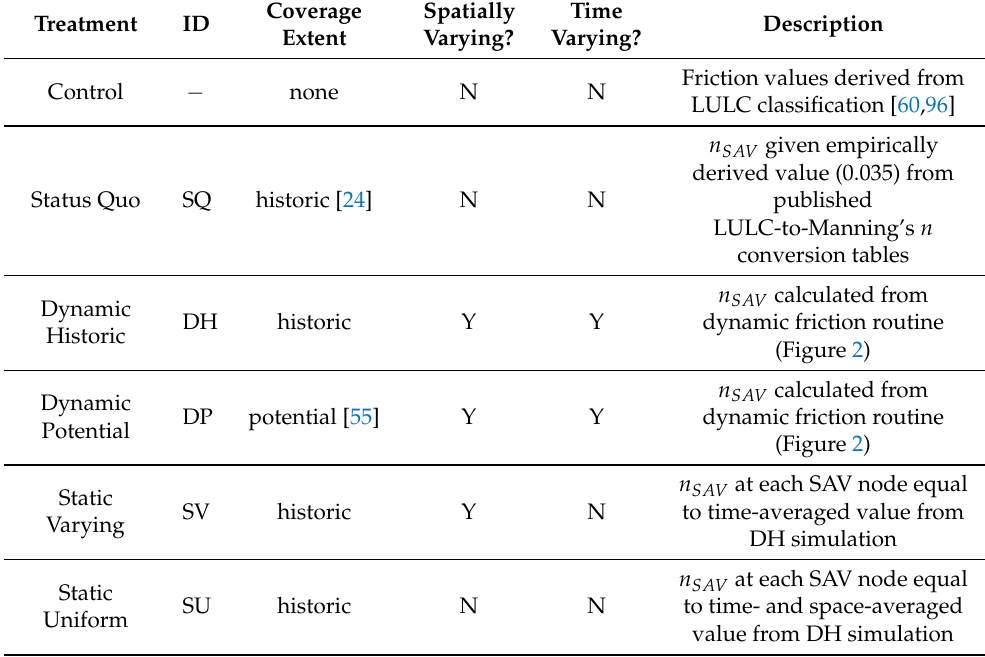
Table 2. SAV parameterization schemes implemented in